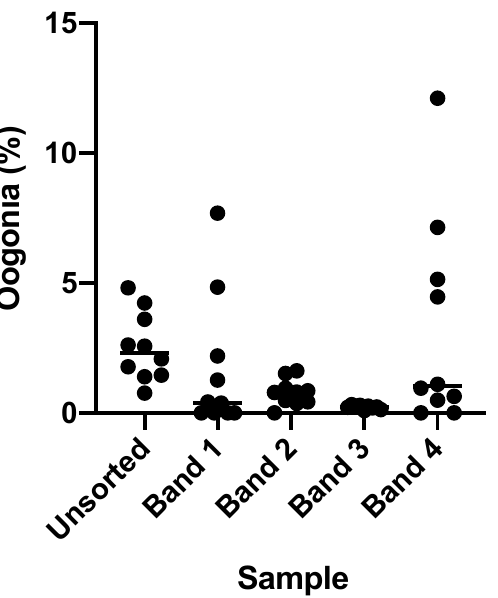
Figure A2. An ovarian tissue suspension (pooled, n = 2) separated on a 20%/40%/60% AllGrad gradient by centrifugation resulted in four cell bands (Bands 1–4). These cell bands were stained with anti-Vasa antibody and Hoechst and cells were counted across 10 fields. None of the cell bands resulted in a significantly higher proportion of oogonial cells in comparison to an unsorted control (Kruskal-Wallis with Dunn’s post-hoc